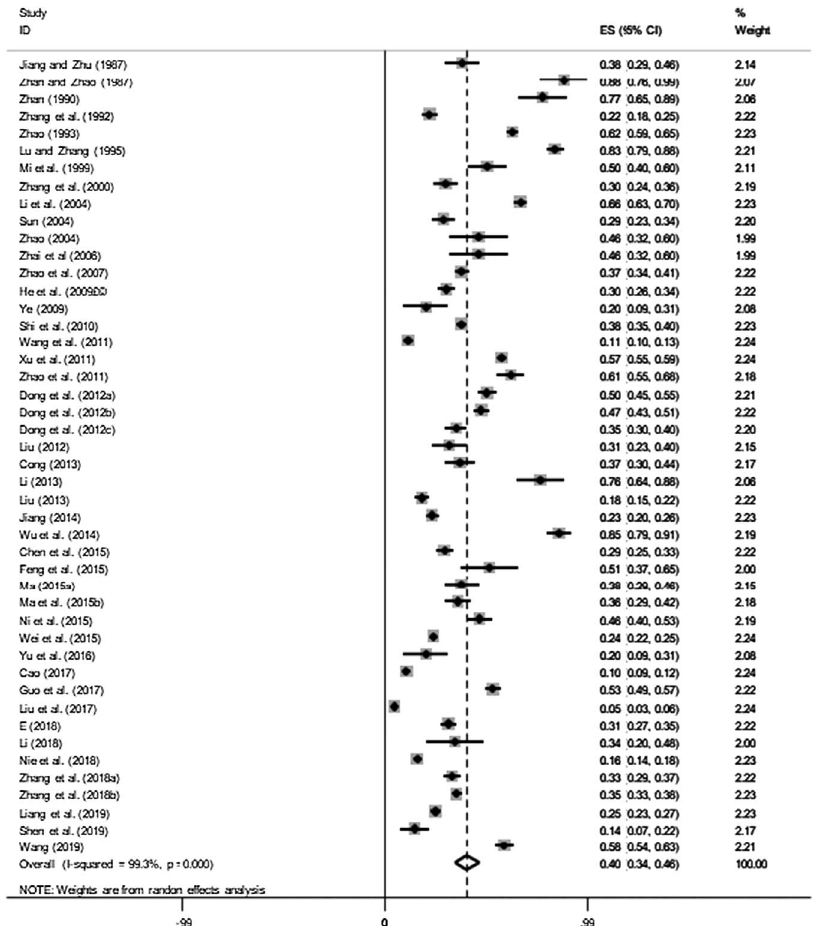
Figure 2. Forest plot of bovine Eimeria prevalence among studies conducted in